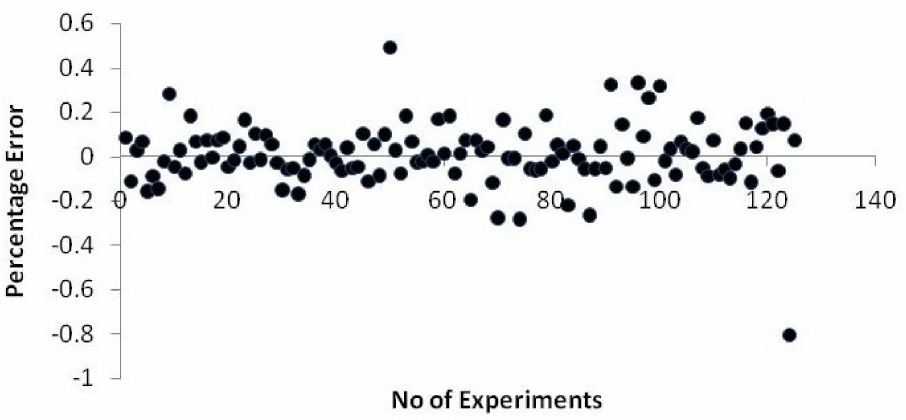
Figure 19. Error graph of network 4-8-3 for angular distortion with time gap between two